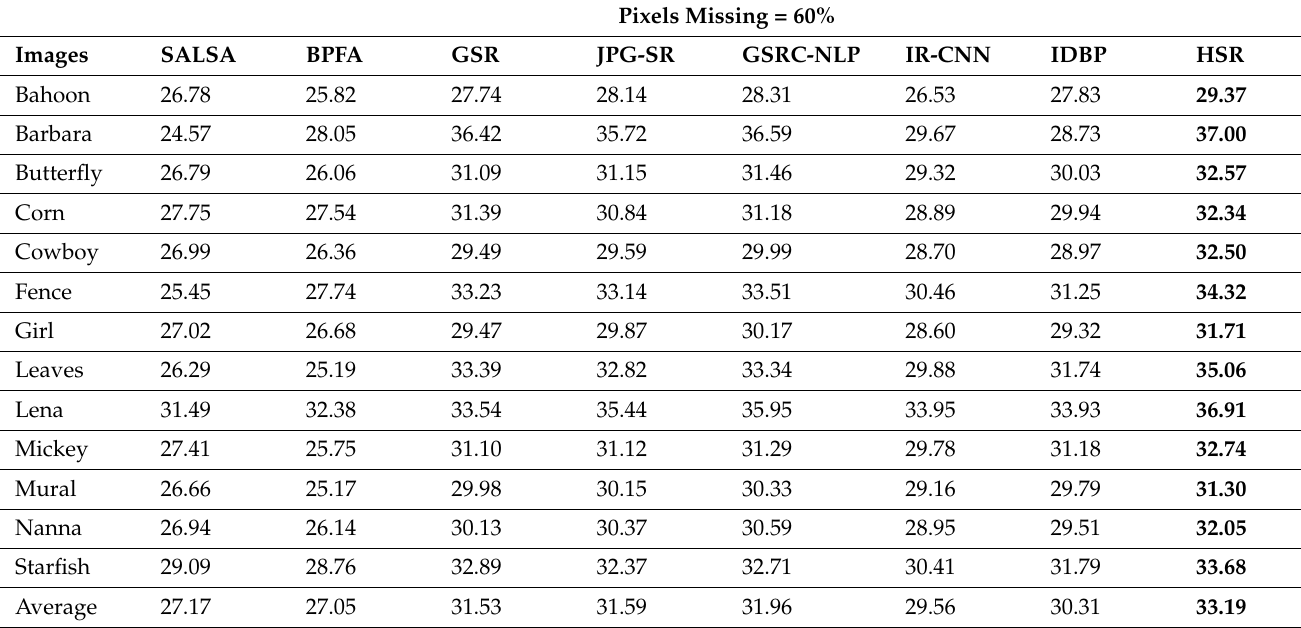
Table 3. PSNR values of our proposed HSR model and other comparison models after image restoration with pixels missing rate 60%.